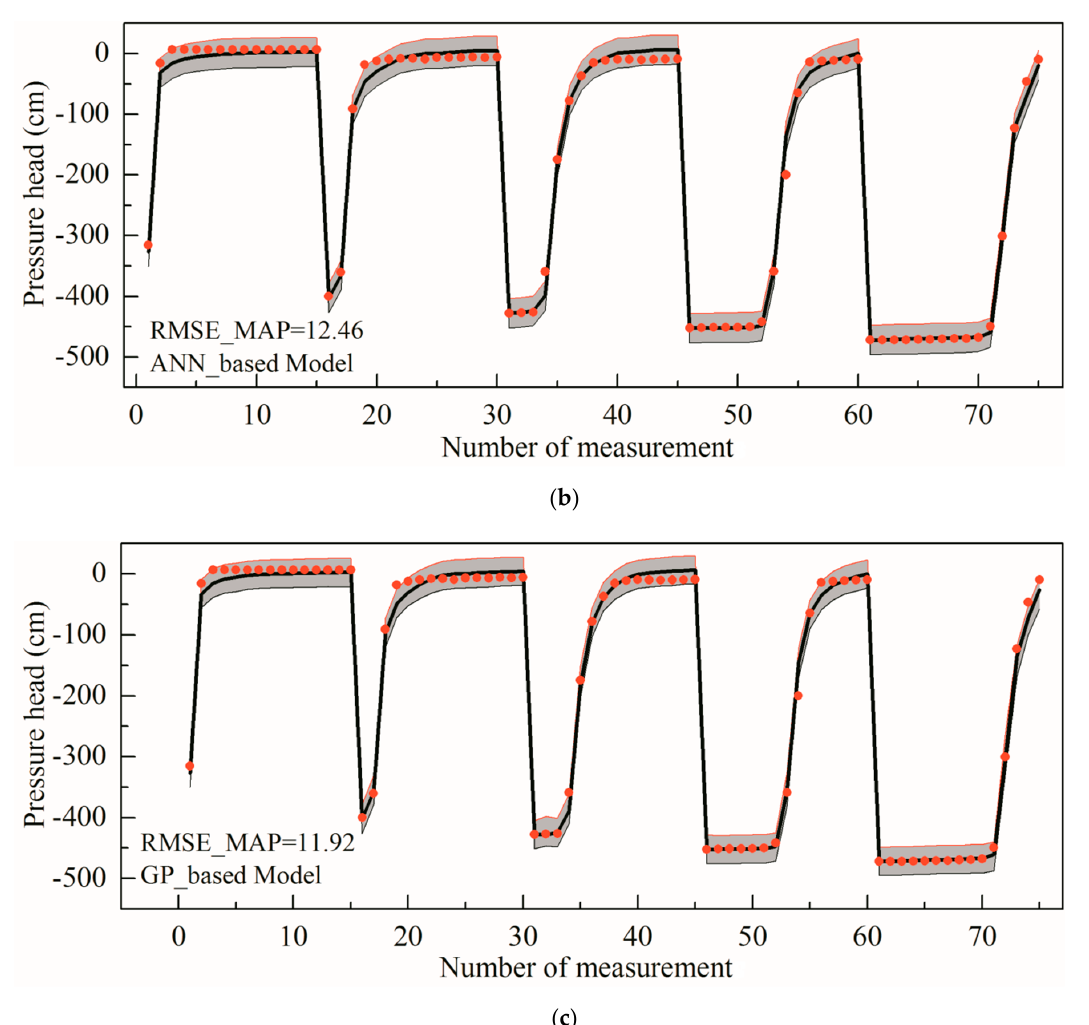
Figure 5. Results of the laboratory infiltration experiment. The red dots are the 75 pressure head measurement values and the grey areas are the 95% confidence intervals of the MCMC simulation results. The solid lines denote the simulated results using the posterior MAP parameters. ( a ) Results based on Hydrus-1D model ( b ) Results based on ANN model ( c ) Results based on GP model